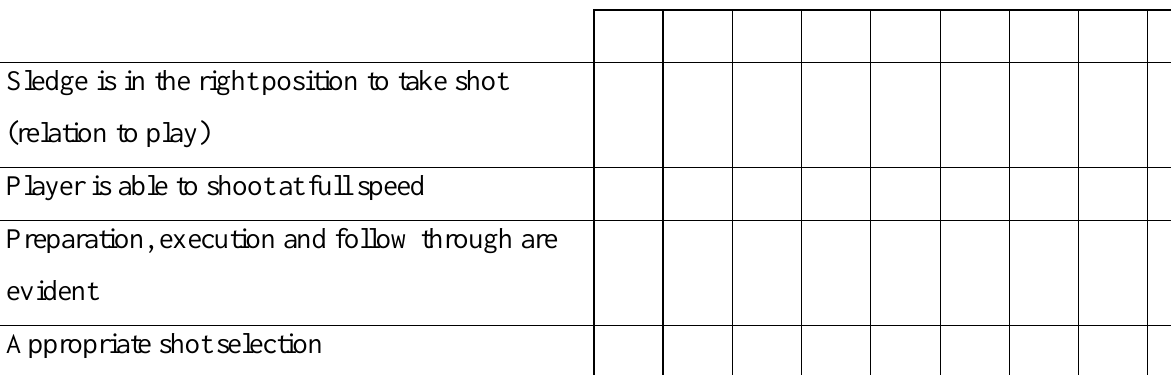
Observation protocol for skill